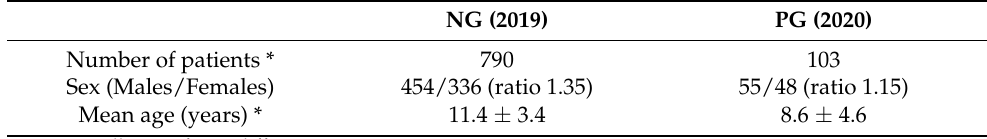
Table 1. Demographic differences between NG and PG.